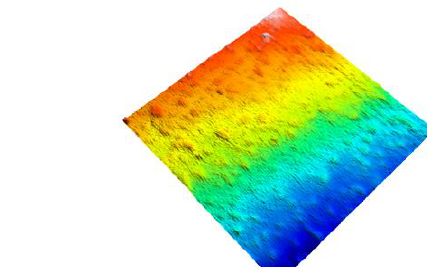
Figure 1. 3D image of Tetric EvoCeram showing the surface of the resin-composite at baseline ( left image ) and after 20,000 cycles of toothbrushing abrasion ( right image ).